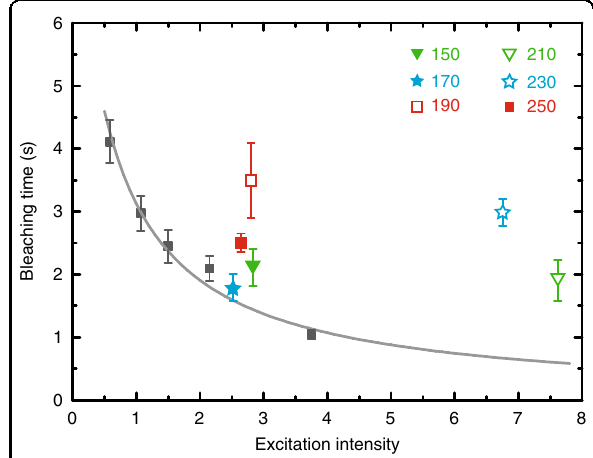
Fig. 5 Measurement of bleaching time t B as a function of b 2 . Measurement of t B on glass as a function of excitation power density displays an inverse proportional relationship (gray squares and gray line). While t B of molecules on antenna-array are all longer than corresponding t B on glass (color symbols represent t B on corresponding